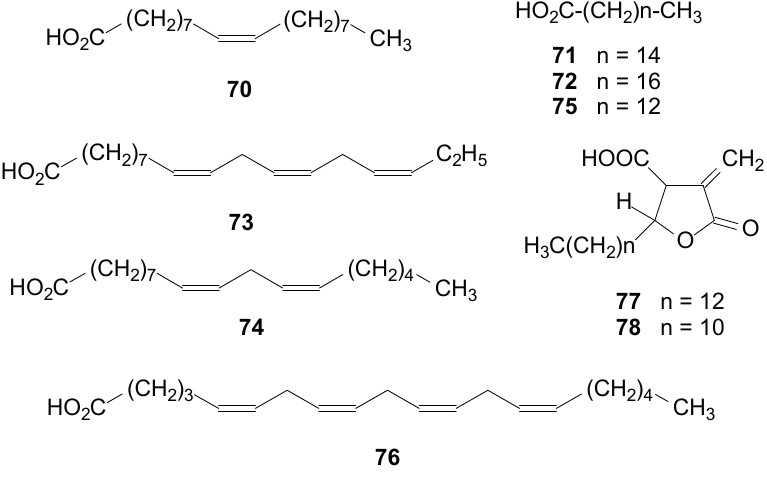
Figure 5. Chemical structures of fatty acids from Ramalina species of lichenized